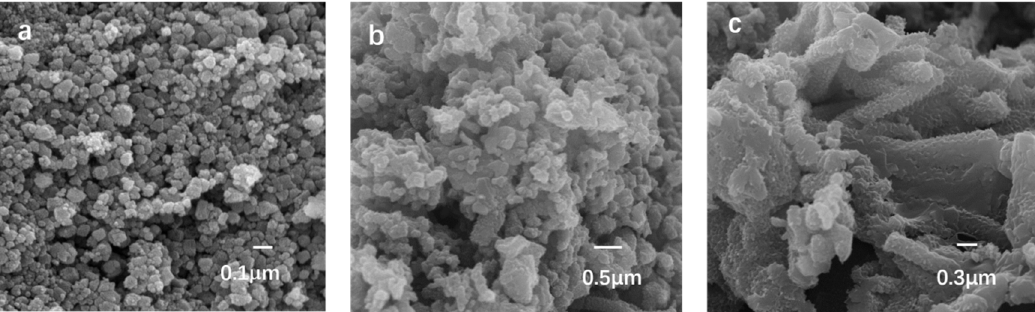
Figure 2. SEM images of: ( a ) nano-NiO; ( b ) PANI/nano-NiO; and ( c ) bulk PANI.